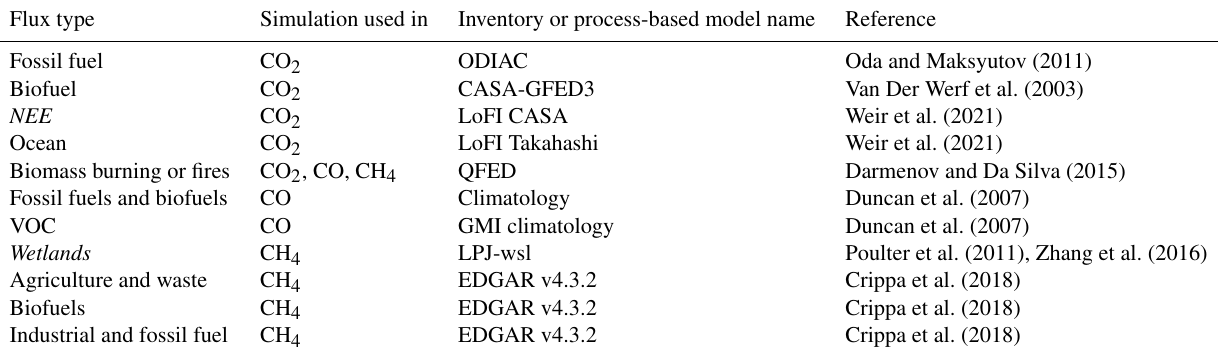
Table 1. Components of fluxes for simulation of atmospheric concentrations of CO 2 , CO, and CH 4 in GEOS. Flux components that are the primary drivers of observed signals within our study domain are distinguished with italics.